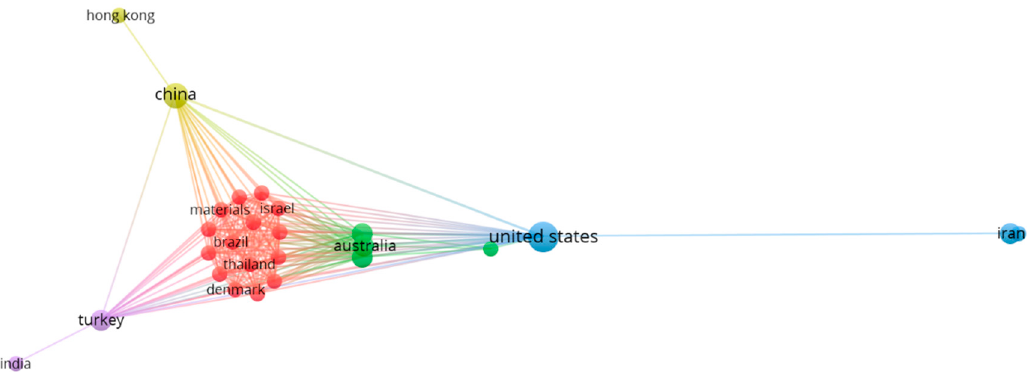
Figure 5. Network map for spatial measurement of research top 10 publications on renewable energy, sustainability and the environment, 2020 (Based on the SciVal database (www.scival.com, accessed on 7 April 2021); data source: Scopus (downloaded on 7 April 2021); copyright: Elsevier B.V.).